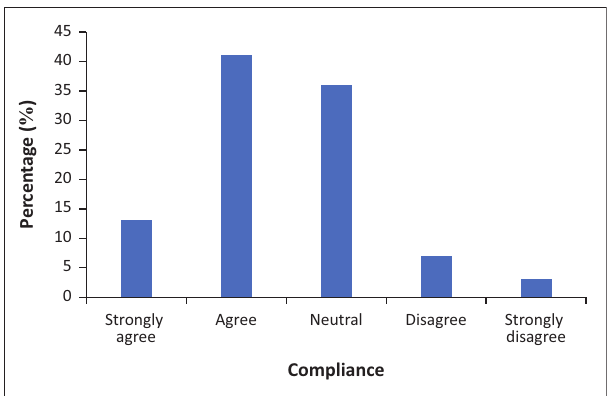
FIGURE 6: Bloemfontein population compliancy to coronavirus disease 2019 regulations.